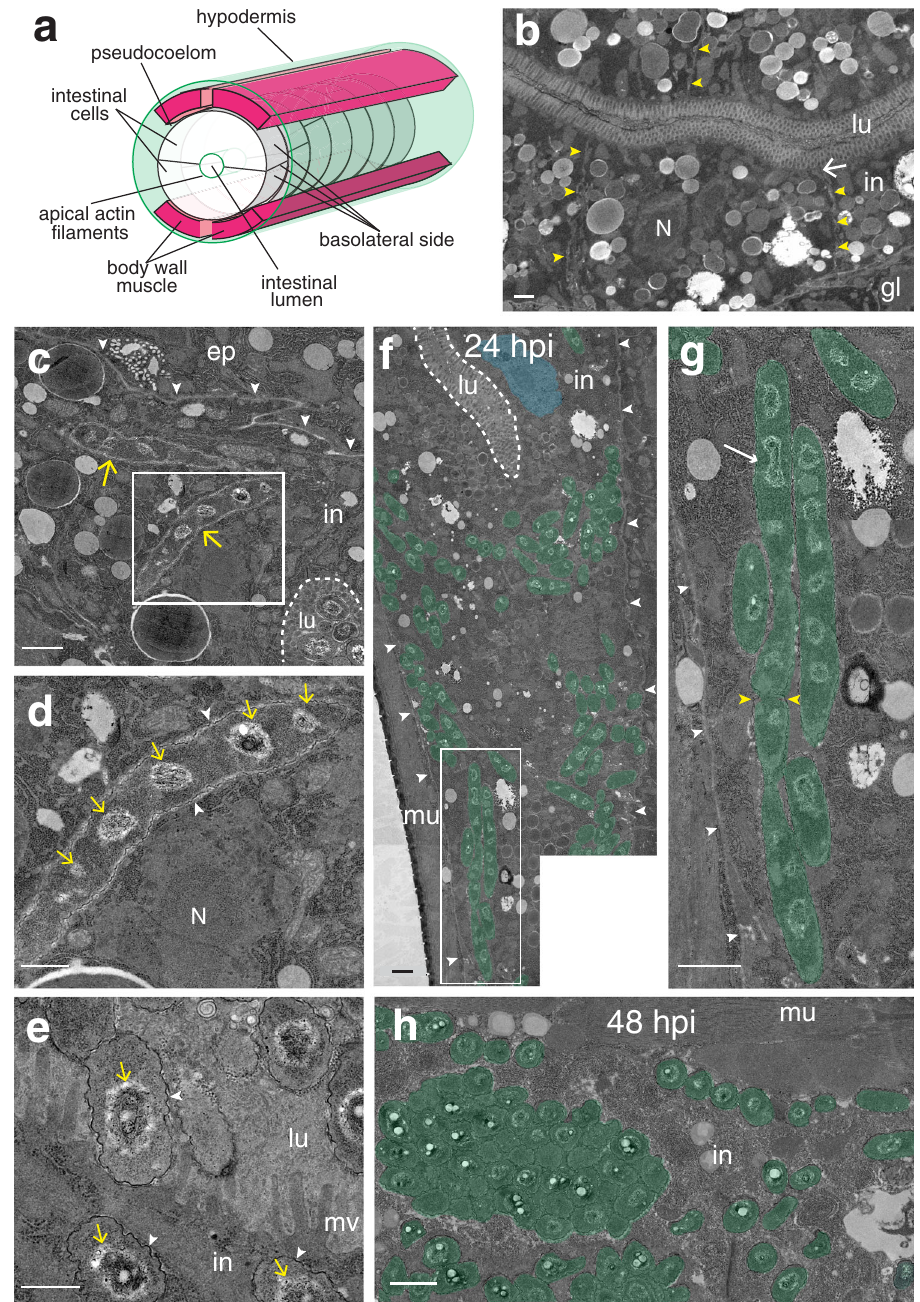
Fig. 2 B. atropi infects and fi laments inside intestinal cells of O. tipulae . a A schematic of relative positions of intestine and surrounding tissues and compartments (not to scale, germline not shown for simplicity). b TEM of intestine of uninfected animals showing almost perpendicular cell-cell membranes delineation (yellow arrowheads), intestinal cell nucleus (N), and electron-dense apical junctions (white arrows). Intestinal cells (in), lumen (lu), and germline (gl) are indicated. c B. atropi fi laments (yellow arrows) in intestinal cells at 24 hpi. The pseudocoelom (white arrowheads), intestinal lumen (dashed line), and epidermis (ep) are indicated. d Inset of white box in c with electron-dense cell wall (arrowheads) outlining the fi lament containing multiple nucleoids (yellow arrows). The intestinal nucleus (N) is indicated. e Coccobacilli in the intestinal cytoplasm (in) and lumen (lu) have the same electron-dense cell wall and large nucleoids as fi laments. Microvilli (mv) are indicated. f A micrograph of an infected animal at 24 hpi with B. atropi coccobacilli and fi laments (pseudocolored green) in the intestine with the intestinal nucleus (pseudocolored blue), pseudocoelom (arrowheads), and body wall muscle (mu) indicated. g Inset of white-boxed region in f with potential dividing nucleoids and septum indicated by arrow and yellow arrowheads, respectively. h A multitude of coccobacilli in infected intestine at 48 hpi. Scale bars are 1 μ m in b , c , f , g , h , and 0.5 μ m in d and e